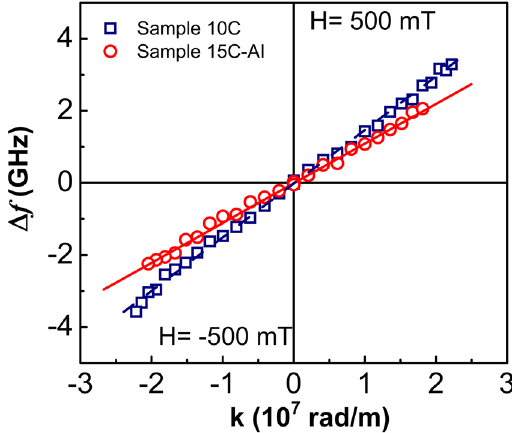
Figure 2. BLS measurements of the full film samples. Frequency difference, Δ f, between Stokes and anti-Stokes peaks is plotted as a function of wave vector k for 500 mT bias field applied parallel to the film plane; k values are inverted for negative bias field − 500 mT, the blue squares are for 10 repeat (10 C) sample while red circles for 15 repeat post deposition treated sample (15C-AI). Line fits to the data of samples 10 C and 15C-AI are shown, as a guide for eyes,by a blue line and a red dashed line,